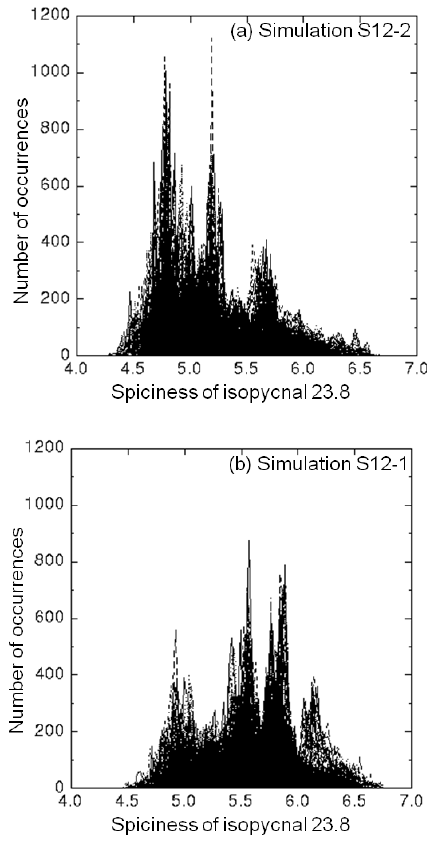
Figure 9. Histogram of spiciness ( (cid:53) ) on isopycnal surface σ 0 = 23.8 in the GW box from 10 years of 5-day snapshots for the 1 / 12 ◦ simulations: (a) S12-2 and (b) S12-1. The GW box (see text) includes 4092 model grid points. 200 bins of 0.015kgm − 3 between the values of 4 and 7kgm − 3 are used to construct the histograms. The peak around spiciness values of 6.2 in S12-1 is due to a single year